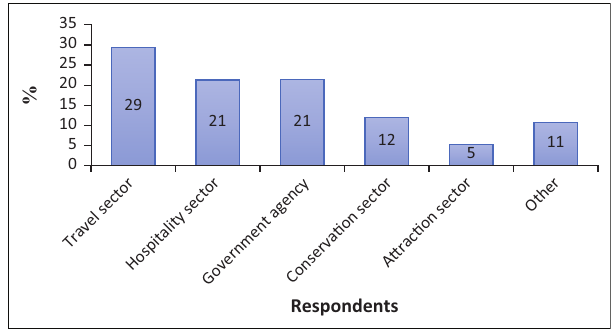
FIGURE 1: Respondents by sector ( n =